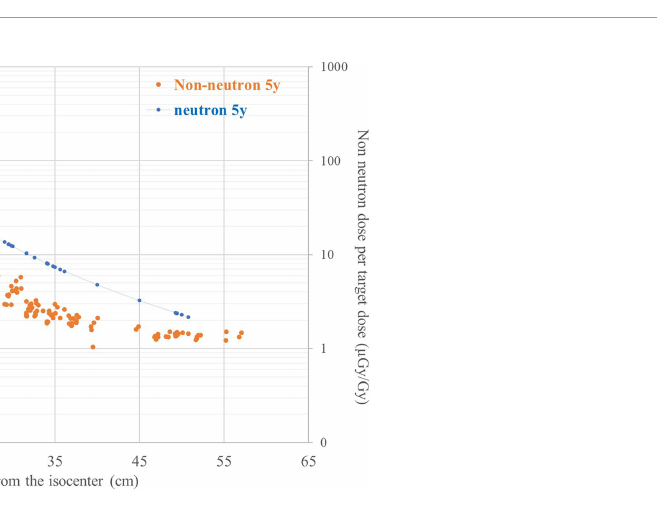
FIGURE 4 | Comparison of neutron and non-neutron dose per target dose as function of the distance from the isocenter for the 5-year-old phantom.